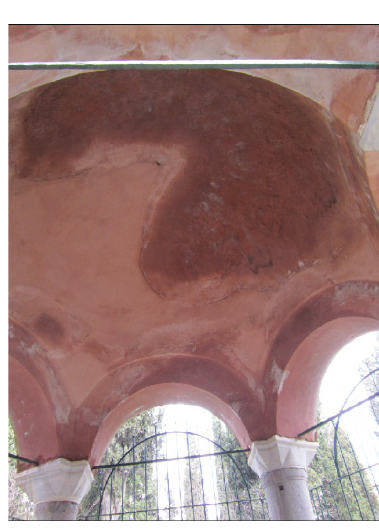
Figure 2: The interior of the